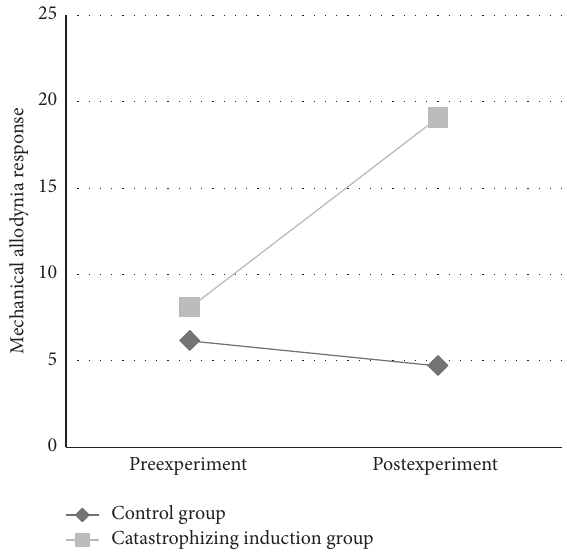
Figure 3: Mechanical allodynia response over time by experimental condition. The interaction of time and condition on mechanical allodynia, controlling for baseline trait PCS and baseline current back pain intensity, was significant (unstandardized 𝛽 = − 6.20, 𝑝 < 0.001 ), with allodynia being significantly greater in the induction condition following the